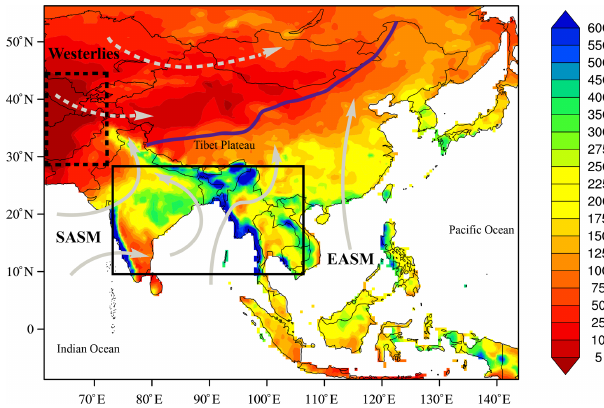
Figure 1. Hydrological distribution and climate systems in the Asian monsoon region (8.75 ◦ S–56.25 ◦ N, 61.25–143.75 ◦ E). The colors indicate the climatological June–July–August mean precipi- tation (mmmonth − 1 ) in 1981–2010, which is based on the monthly global land surface precipitation of the Global Precipitation Clima- tology Centre Full Data Reanalysis version 7. The solid and dashed black boxes indicate the relatively wettest area (RWA) and the rela- tively driest area (RDA),